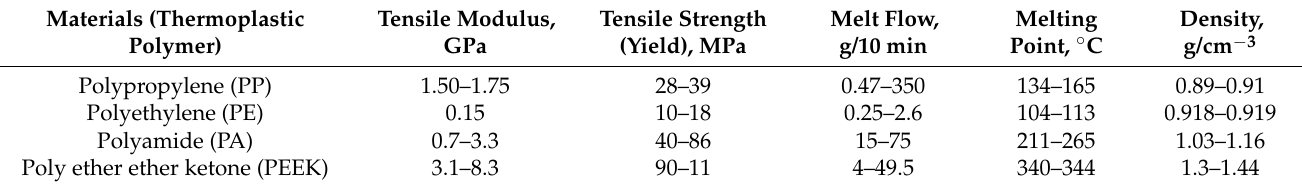
Table 1. Reference values of thermoplastic polymers. Authors’ own table from